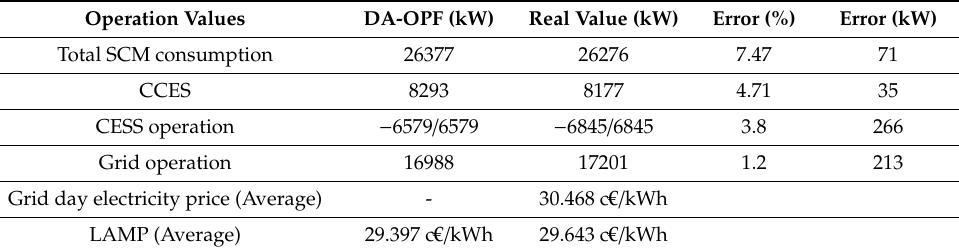
Table 3. One-day OPF simulation (winter day).